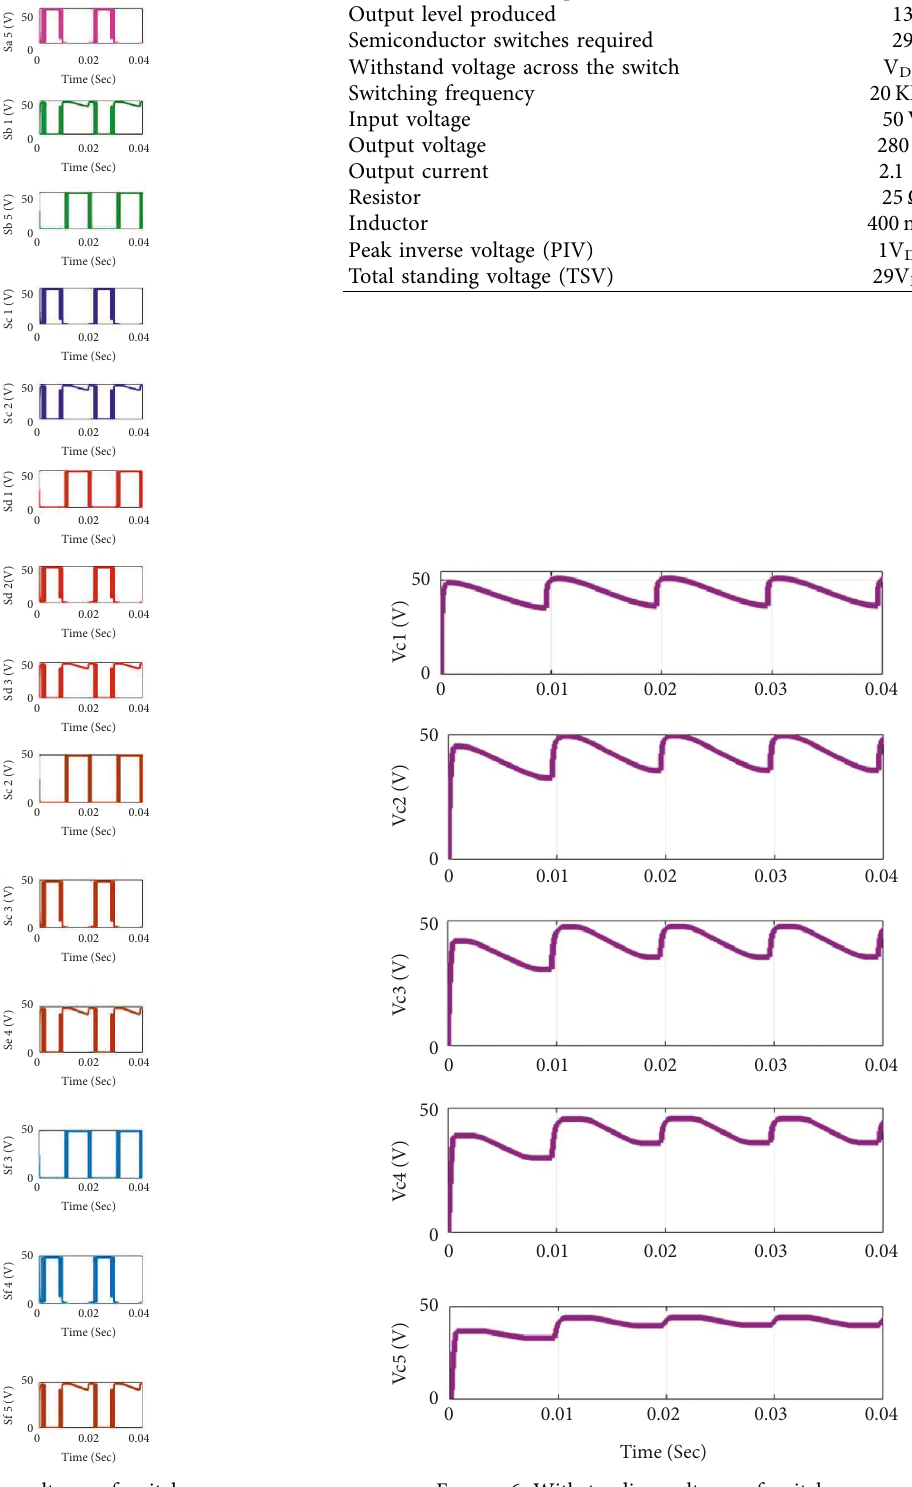
Figure 5: Withstanding voltages of switches.